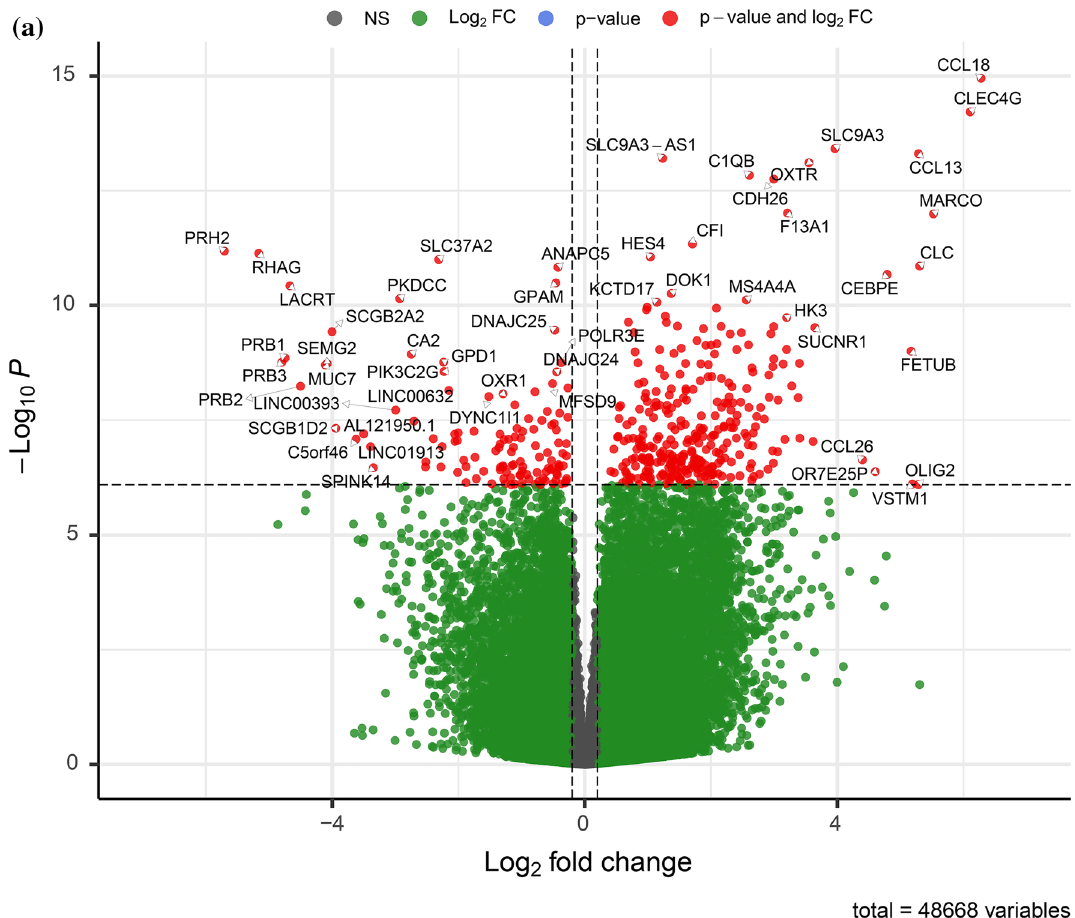
Figure 3. Gene expression of all expressed genes. Vulcano plot showing the negative logarithm of the p -value on the y-axis and the fold change of all expressed genes from the comparison of ( a ) Polyp mucosa versus non-polyp mucosa from the same CRSwNP patient and ( b ) Healthy control patient mucosa versus non-polyp mucosa from CRSwNP patient. DESeq2 R package analysis, including sex and age as